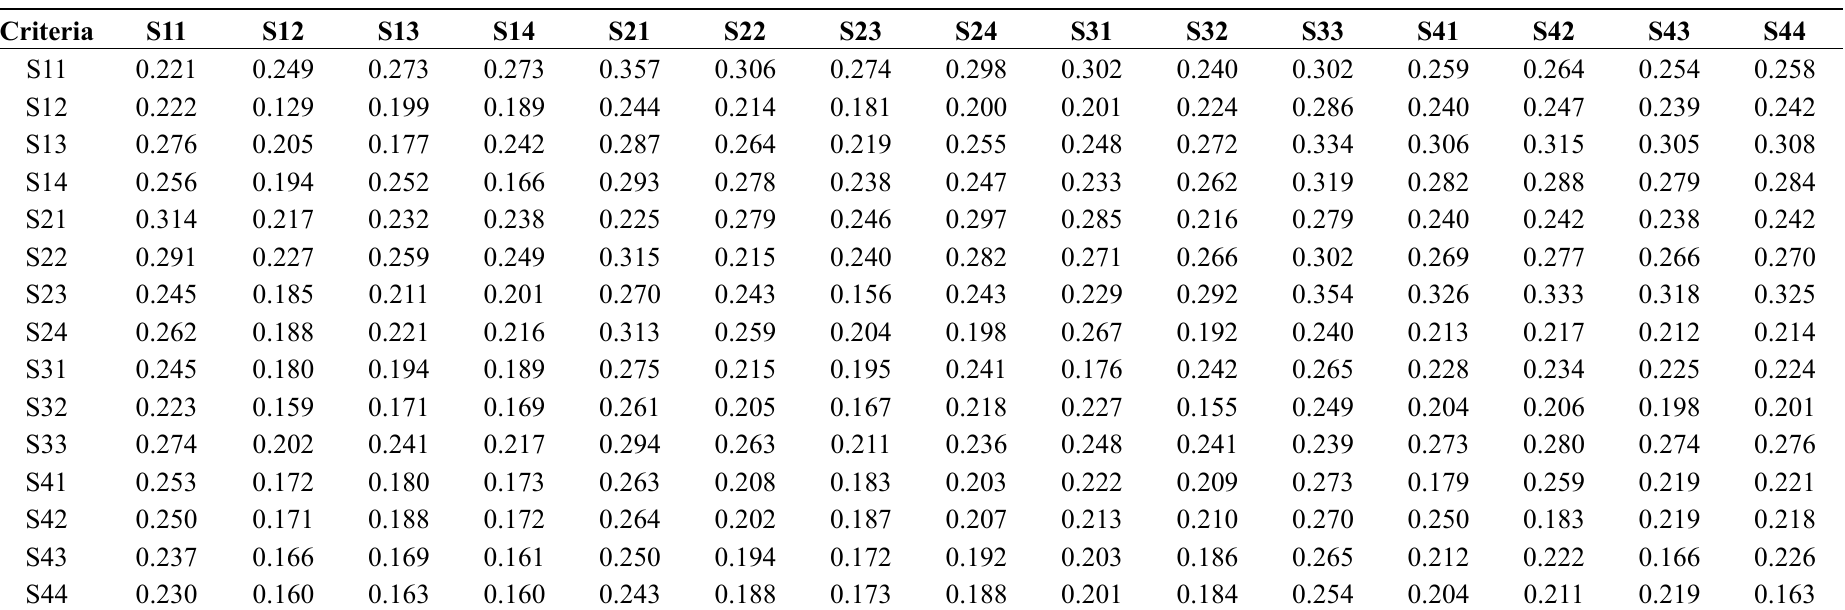
Table 6. Total-Relation Matrix (T) for